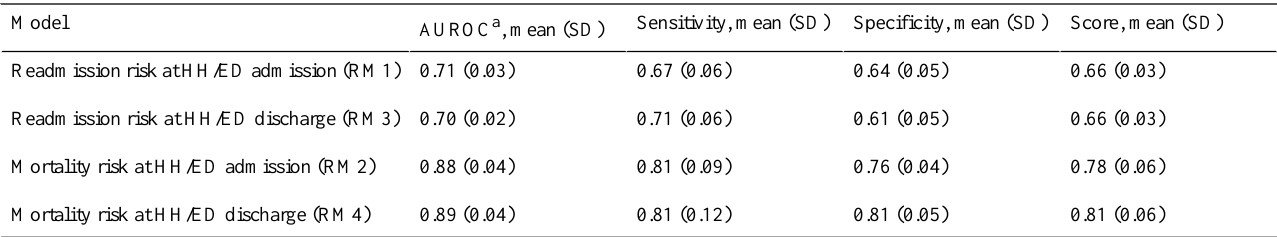
Table 4. Average results of the performance of the 4 home-hospitalization/early discharge (HH/ED) predictive risk models